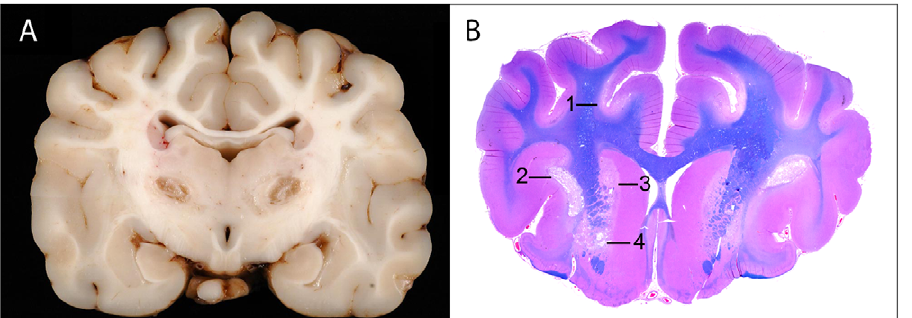
Figure 2. Brain of dog # 6. A . Transverse section of brain with bilaterally symmetrical areas of cavitation due to encephalomalacia in the thalamus. B. Same dog; macrophotograph of a transverse section of brain rostral to Figure 2A illustrating bilaterally symmetrical areas of polioencephalomalacia [2] or of necrosis with incipient malacia [1,3,4] in cortex deep in the sulci [1], in the claustrum [2], in caudate nucleus [3] and the globus pallidus [4] (HE-LFB